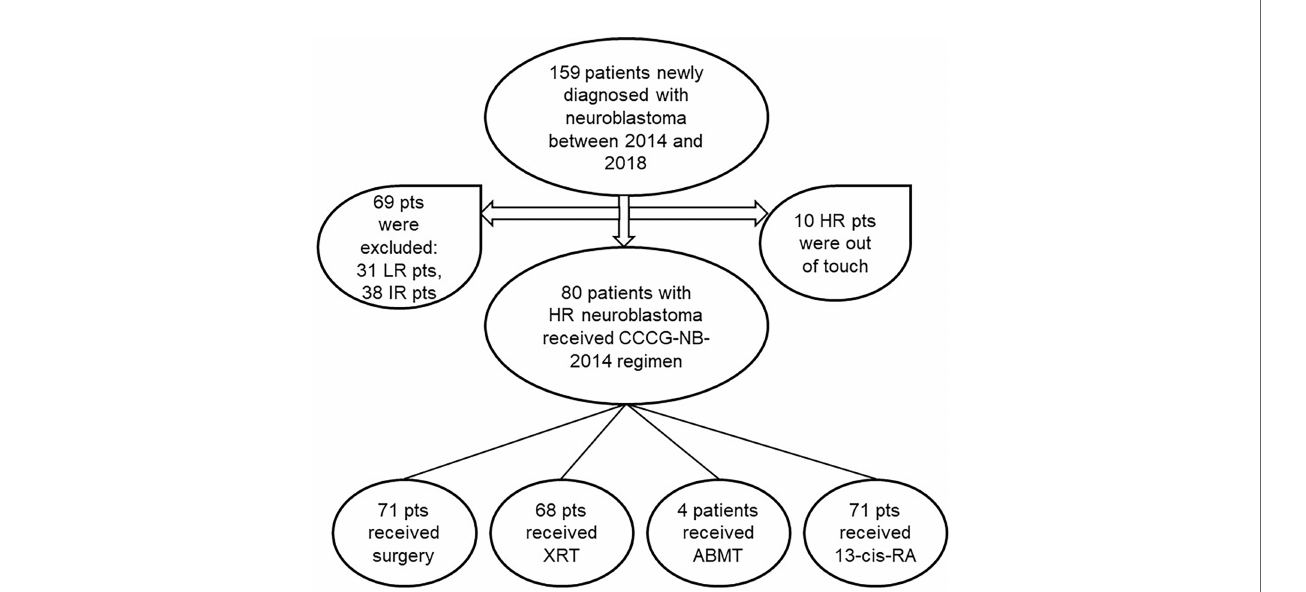
FIGURE 1 | Flow diagram of patients in the study. pts, patients; LR/IR/HR, low/intermediate/high-risk; XRT, external beam radiotherapy; ABMT, autologous bone marrow transplantation; Cis-RA, cis-retinoic